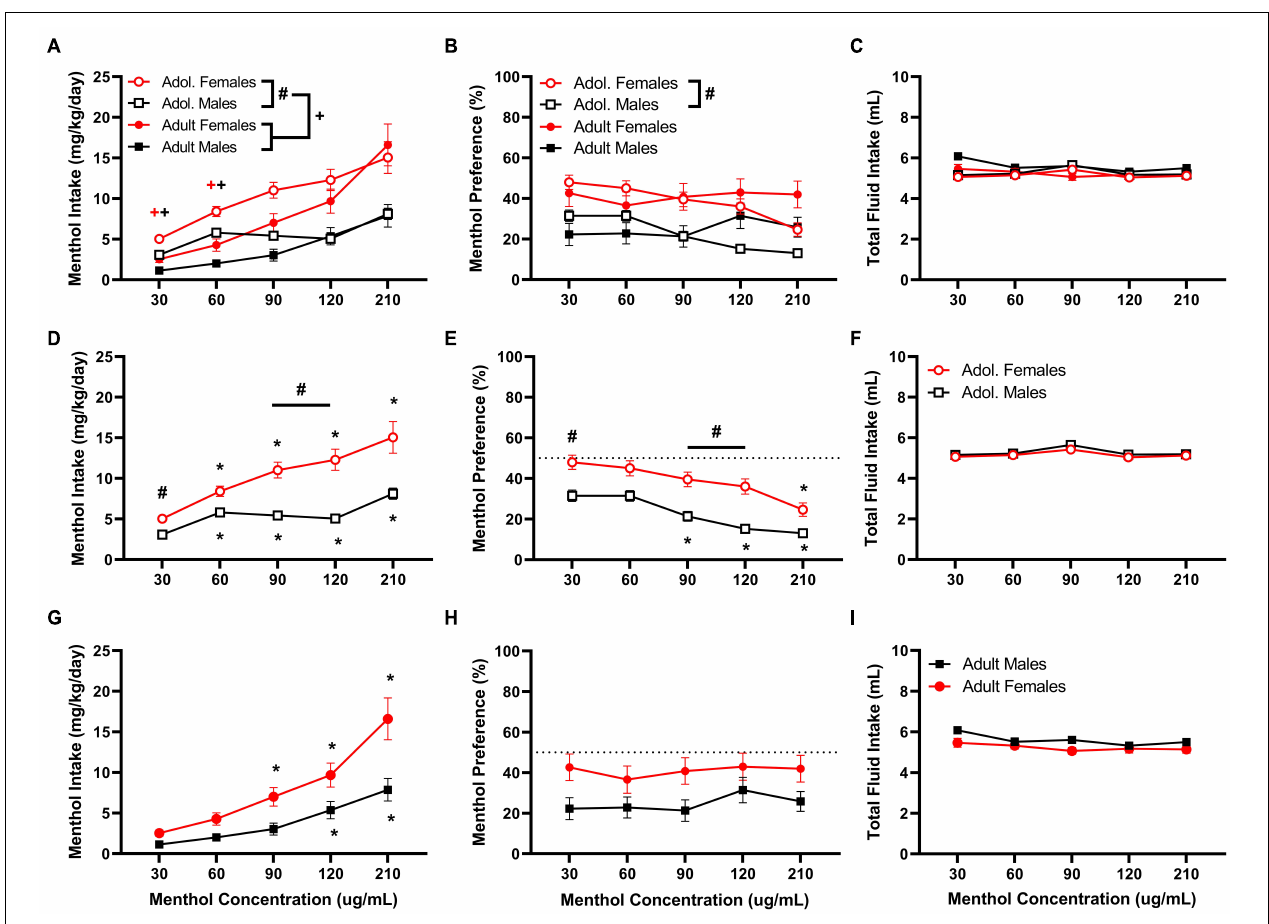
FIGURE 1 | Oral menthol intake and preference in adolescent and adult male and female DBA/2J mice. Mice were given a choice of DI water or menthol solutions (30–210 µ g/mL) in a within-subject manner in the two-bottle choice paradigm. Concentrations of menthol increased every three days, and the averaged values from all 3 days were used to calculate menthol intake and preference. Intake is calculated as mg of drug per kilogram (mg/kg) of body weight and preference as the volume of drug solution consumed as a percentage of the total fluid consumed. (A,D,G) Average menthol intake (mg/kg/day), (B,E,H) menthol preference (%), and (C,F,I) total fluid intake are shown. Data are presented as the mean ± SEM of 10–20 mice/sex/age. Results are based on a RM three-way ANOVA with age, sex, and menthol concentration as factors. + P < 0.05 vs. adults. * P < 0.05 vs. 30 µ g/mL menthol solution. # P < 0.05 vs.